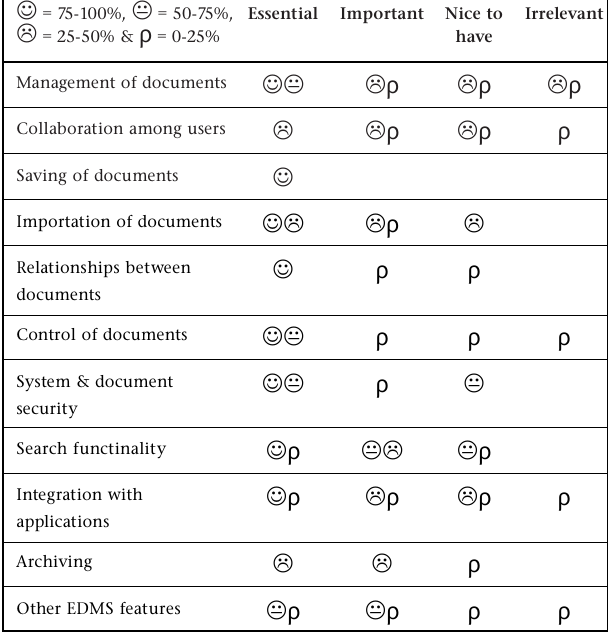
Figure 3: Summary of the needs-analysis survey about electronic document management Figure 3 represents a summary of the survey